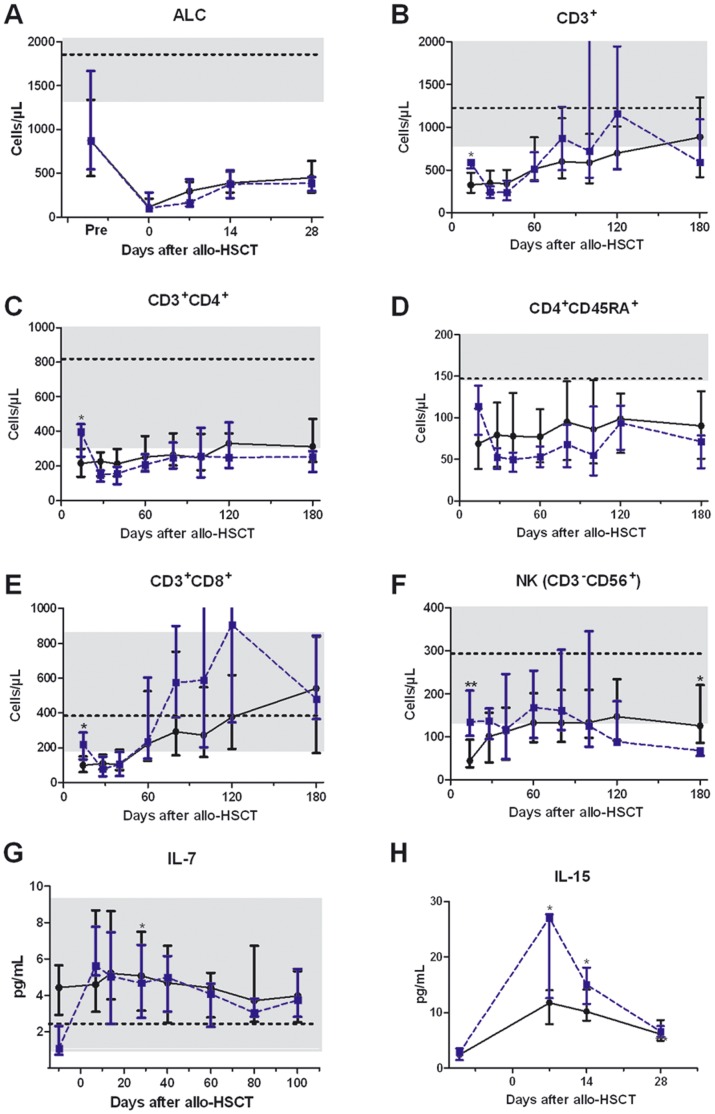
Median ALC (A), median MNC-subset cell counts (B–F), and median IL-7 (G) and IL-15 (H) after allogeneic hematopoietic cell transplantation following 2 Gy (continuous line) or 4 Gy (broken line) total body irradiation.The error bars shows the 25th and 75th percentiles. For ALC and MNC-subset, horizontal lines show the medians and the grey square the limit of normal value (if non truncated) in 47 healthy volunteer donors; for IL-7, horizontal line shows the medians and the grey square the limit of normal value according to the manufacturer brochure. *, P<0.05; **, P<0.01; ***, P<0.001.